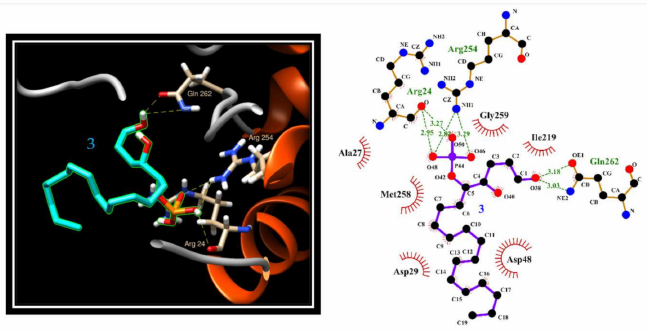
Figure 11. Interaction of compound 3 within the second aryl binding site of PTP1B enzyme.